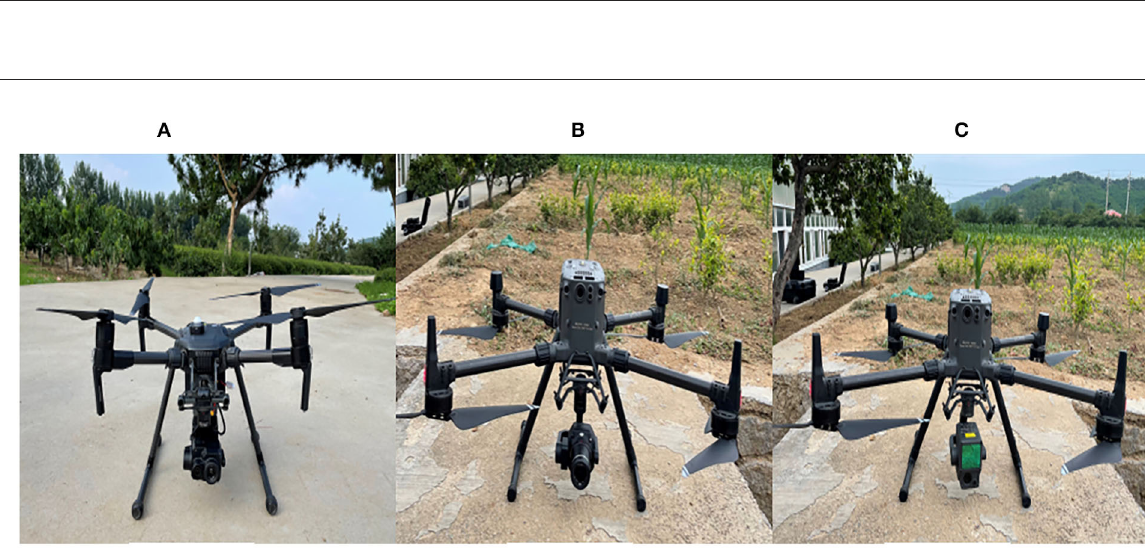
FIGURE3 (A) M200 V2 carries with MS600 and Meditation XT2; (B) the M300 RTK carries Meditation P1; (C) the M300 RTK carries with Meditation